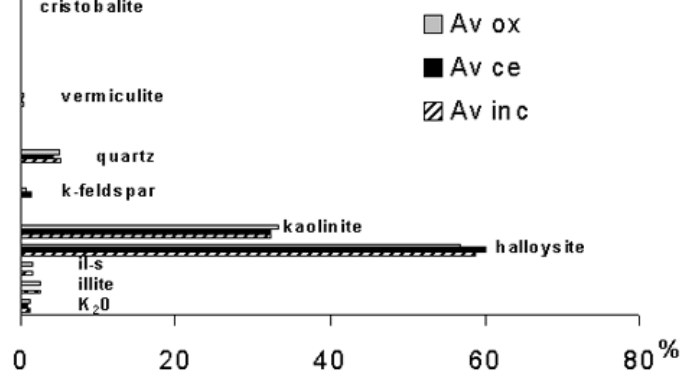
Fig. 2 – The overall distribution of the minerals along the three mines. The lines represent the average of mineral % in each mine. Av = average, Inc = Incepa, Ce = Ceramarte, Ox =